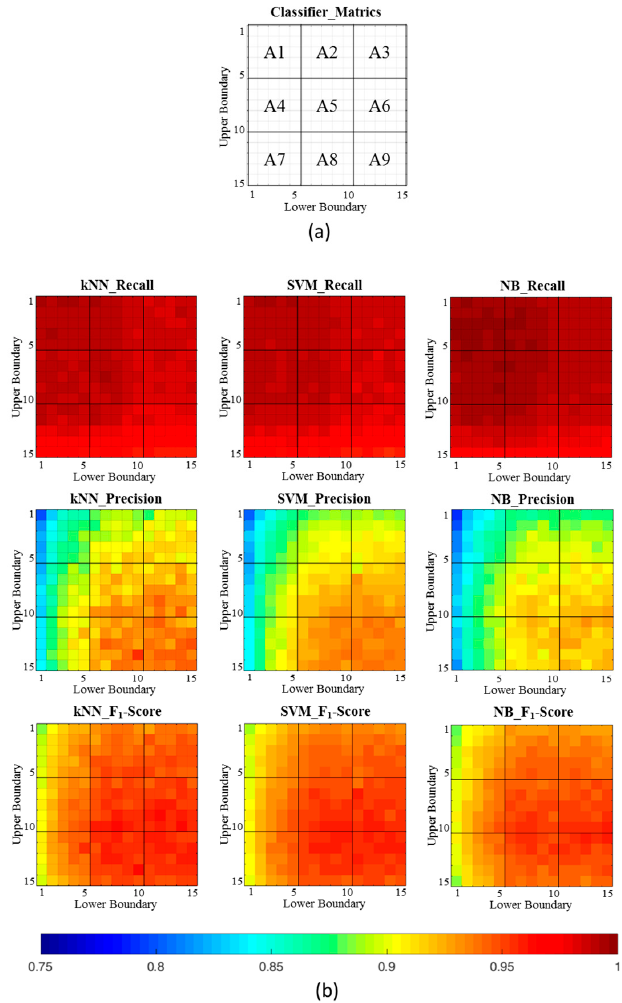
Figure 7. Overall performance comparison of different classifiers. ( a ) An example of performance divided into nine areas. Each area can be defined as the average performance of 25 pairwise combinations of different upper and lower boundaries. ( b ) Pairwise combinations of different upper and lower boundaries (samples) are shown in each performance metric. Table 4. The overall performance comparison of different classifiers for four cleaning tasks. Measure Metric